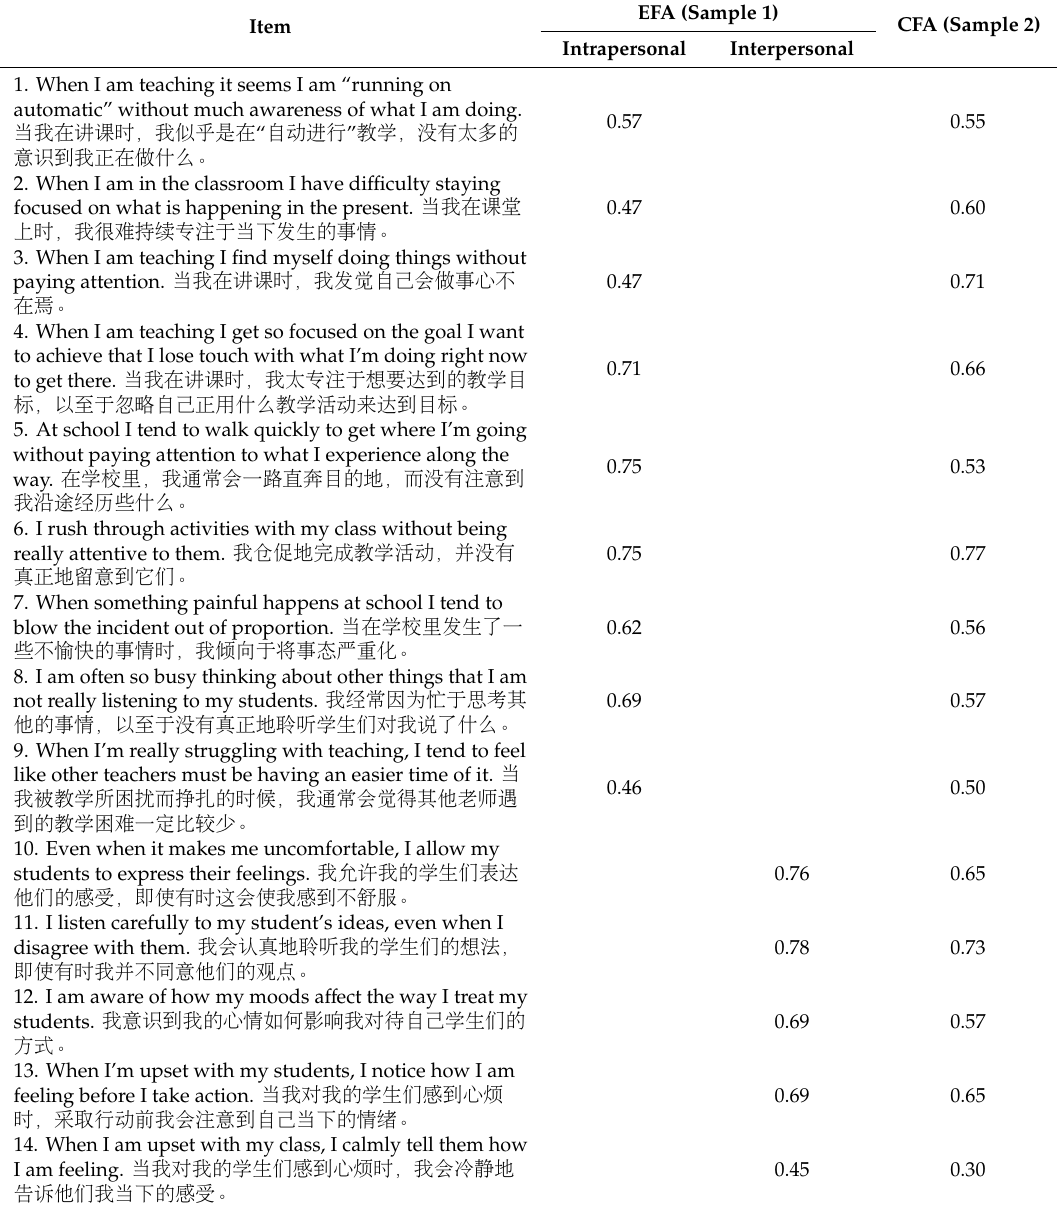
Table 1. Items and factor